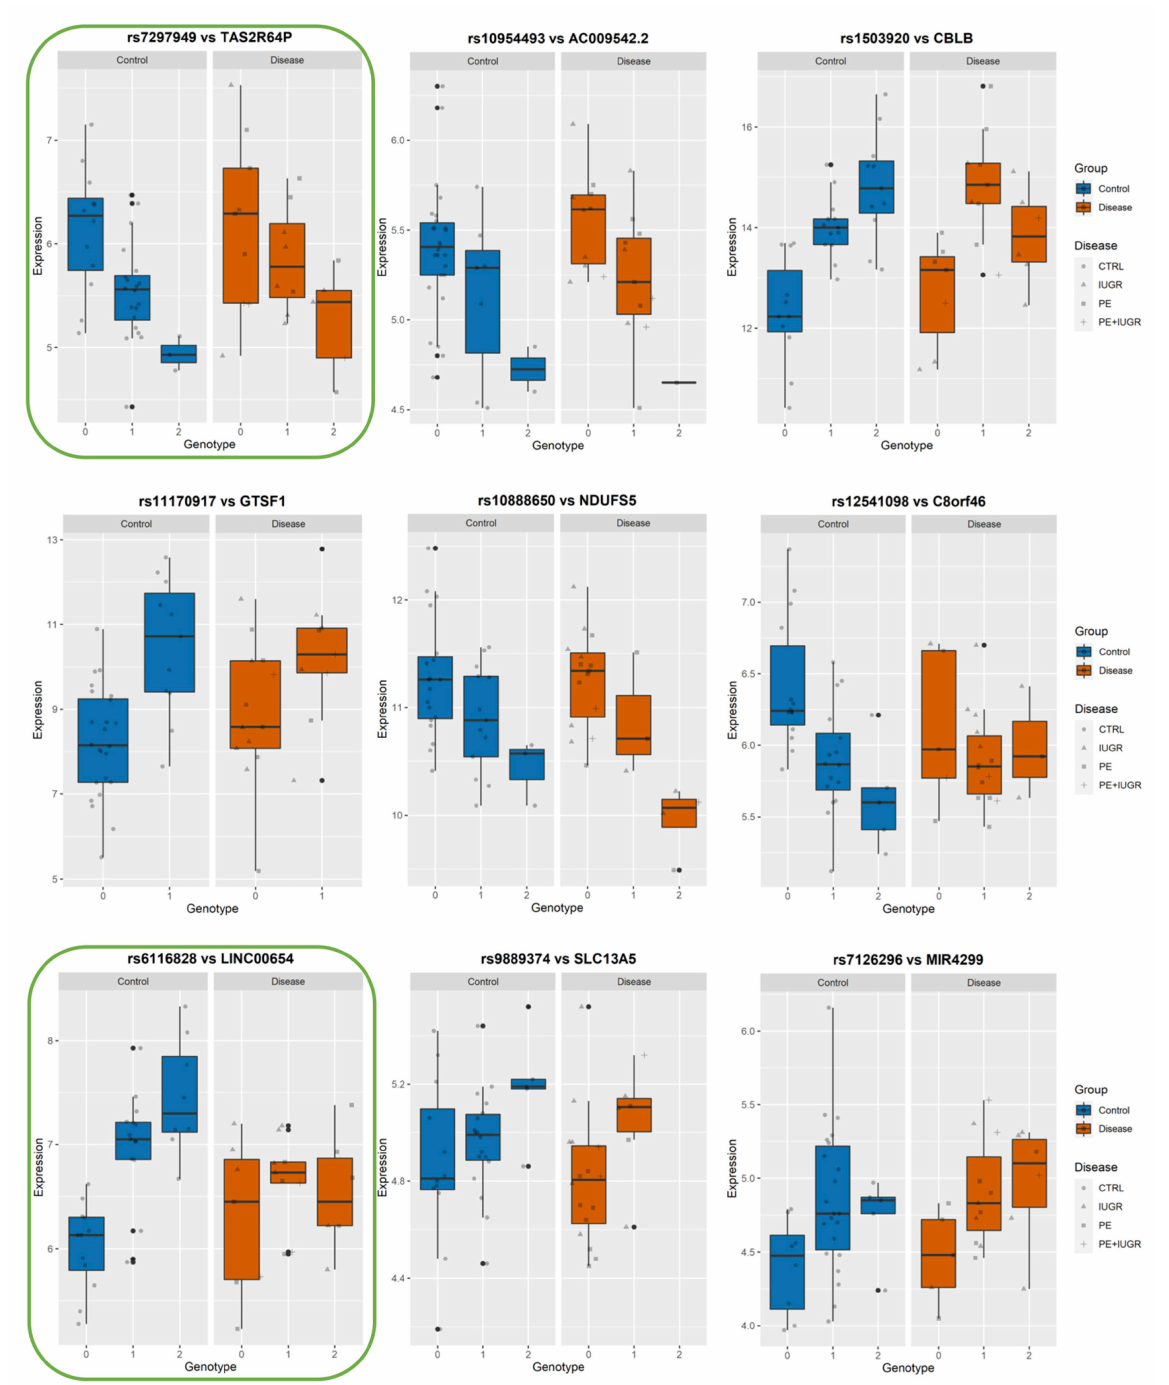
Figure 7. Boxplots of eGene expression in relation to the best-eSNP genotype, stratified by Group: Control vs. Disease. eGenes TAS2R64P, AC009542.2, CBLB, GTSF1, NDUFS5, C8orf46, LINC00654, SLC13A5, MIR4299.The genotype of each SNP is expressed as 0, 1, 2, and the gene expression data corresponds to the raw data as mean fluorescence value. CTRL = Control; IUGR = Intra-uterine Growth Restriction; PE = Preeclampsia. Genes discussed in the text, because of their relevance to placental biology, are highlighted in